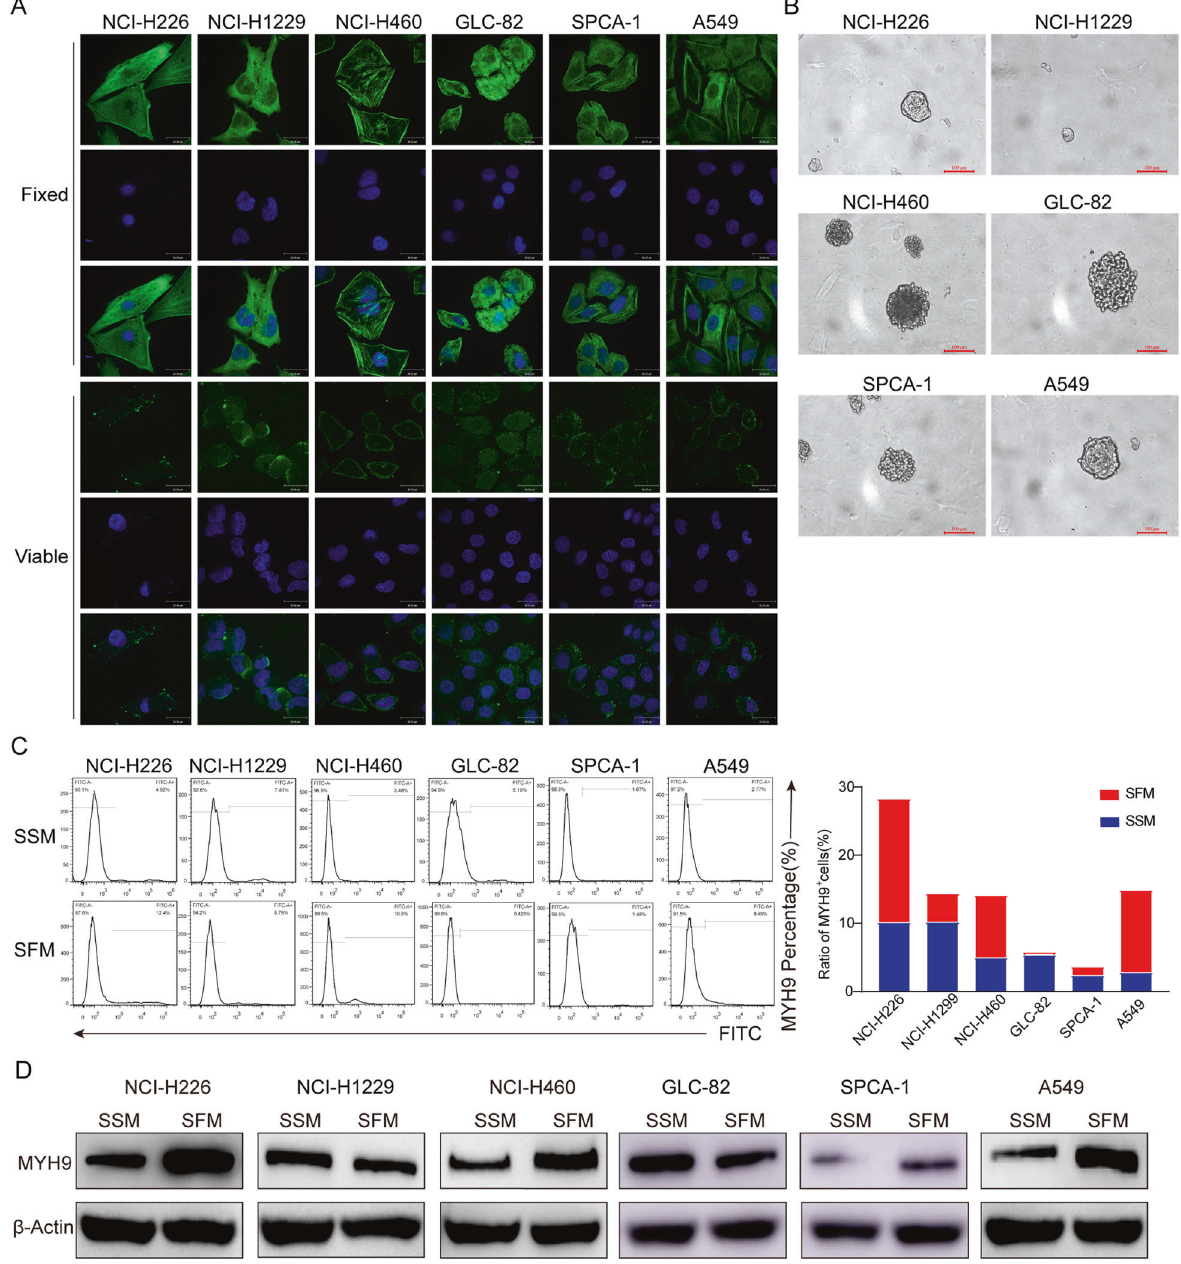
Fig. 1 Enrichment and expression of MYH9 in spheroid cells of lung cancer. A Expression of MYH9 in lung cancer cell lines (GLC-82, SPCA-1, NCI-H460, A549, NCI-H226, and NCI-H1299) (scale bar, 30 μ m). B Serum-free suspension culture of LCCs. C Analysis of the proportion of MYH9- positive cells in parent and spheroid cells of lung cancer by fl ow fl uorescence. D The expression level of MYH9 in parent and spheroid cells of lung cancer cell lines. Data are expressed as mean ± SEM of three independent experiments. * p < 0.05, ** p < 0.01, compared to